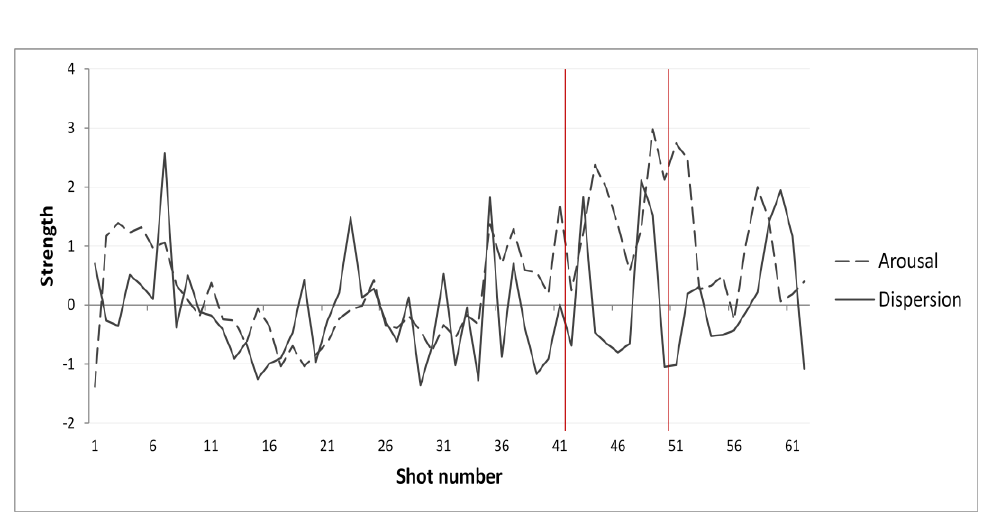
Figure 4 . Arousal and gaze points dispersion scores per shot (version A). Data are normalized. Vertical red lines correspond to junctions 1 and